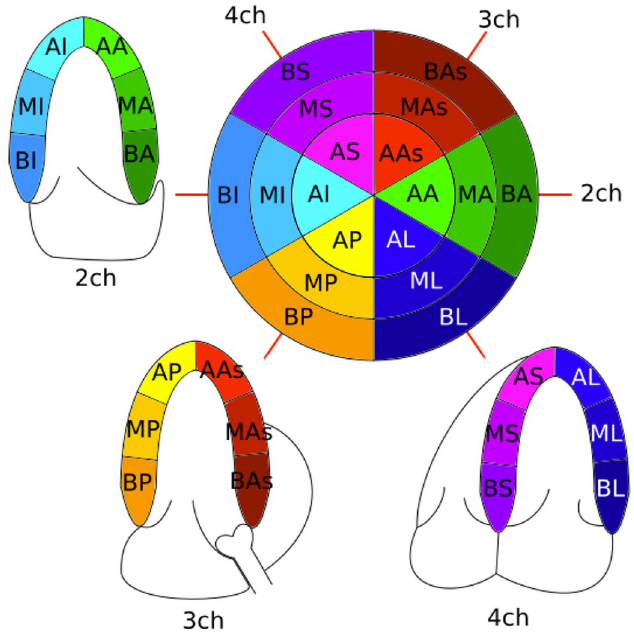
Fig 1. Bull’s-eye representation of myocardial LV segments and their relation to the different echocardiographic views (4ch: 4-chamber, 2ch: 2-chamber, 3ch: apical long axis). In each label, the first letter corresponds to B: Basal, M: Mid, and A: Apical. The second letter correspond to S: Septal and L: Lateral for the 4ch, I: Inferior and A: Anterior for the 2ch, P: Posterior and As: Anteroseptal for the